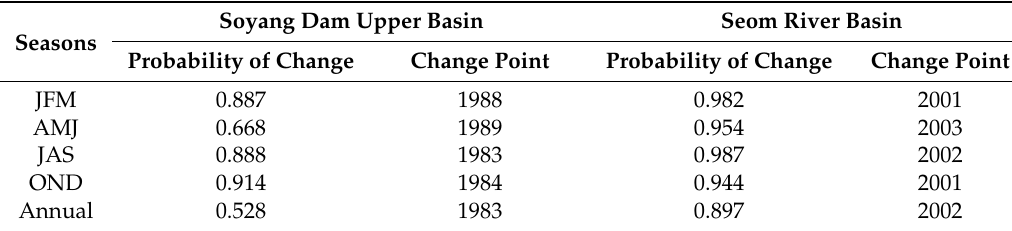
Table 4. Results of change point detection by the Bayesian change point (BCP) analysis.